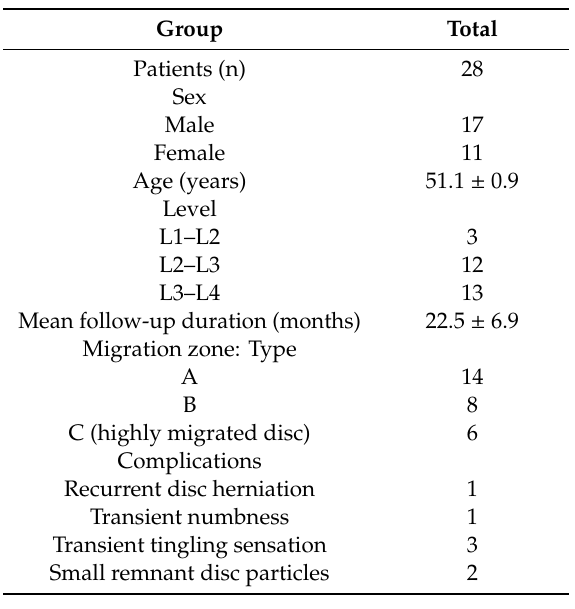
Table 1. Demographic characteristics of 28